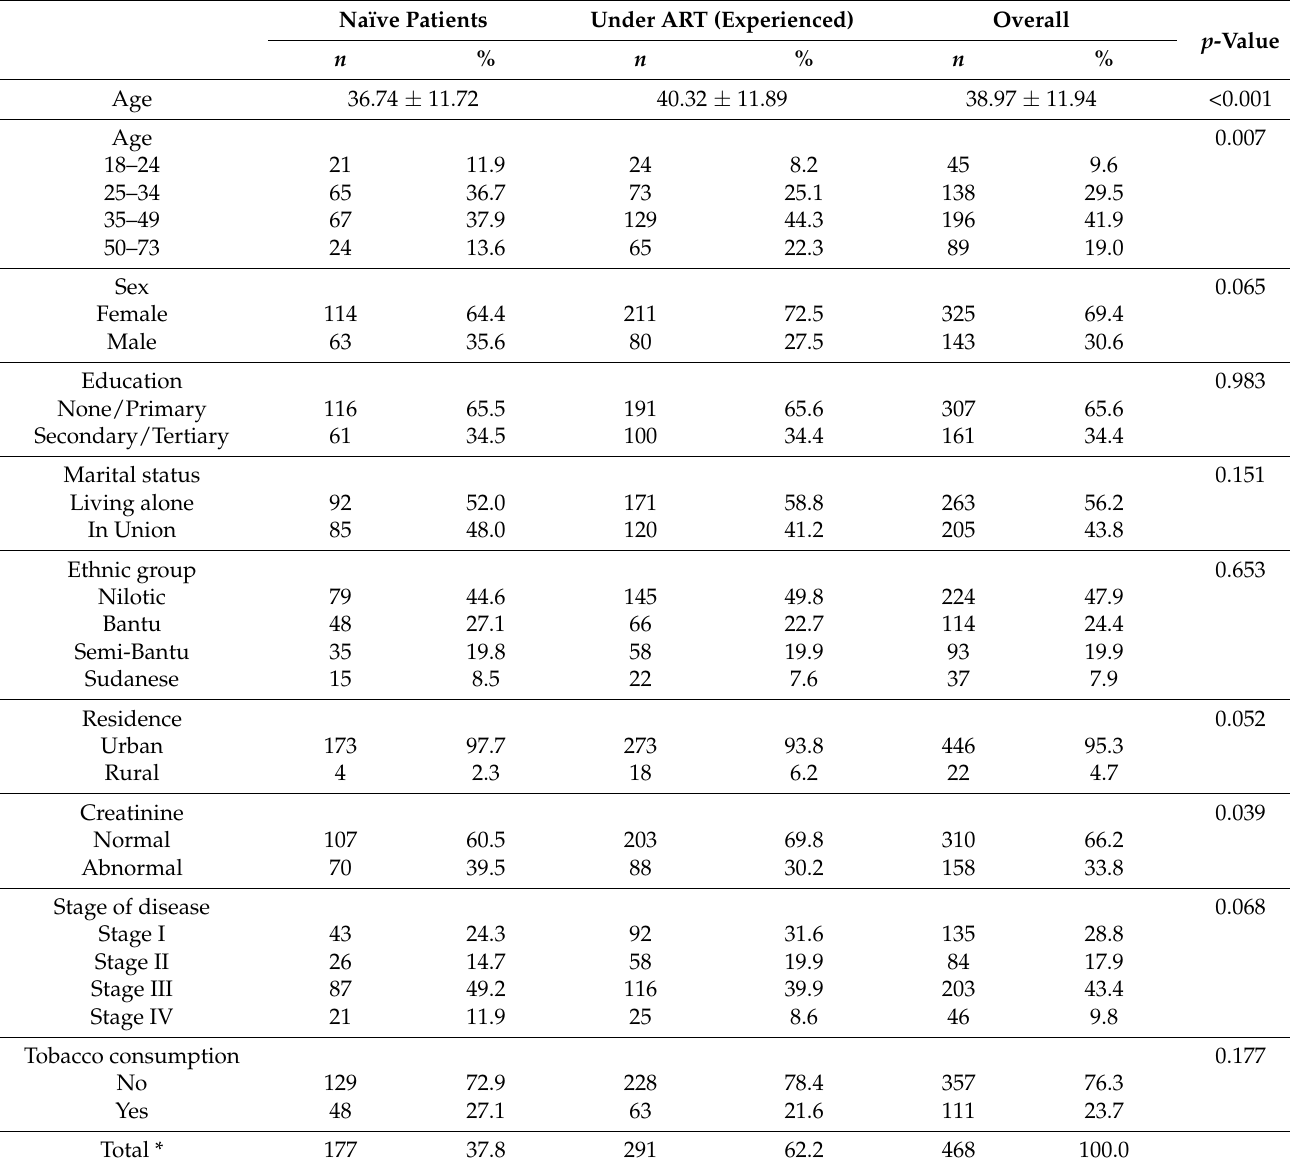
Table 1. Background characteristics. Naïve